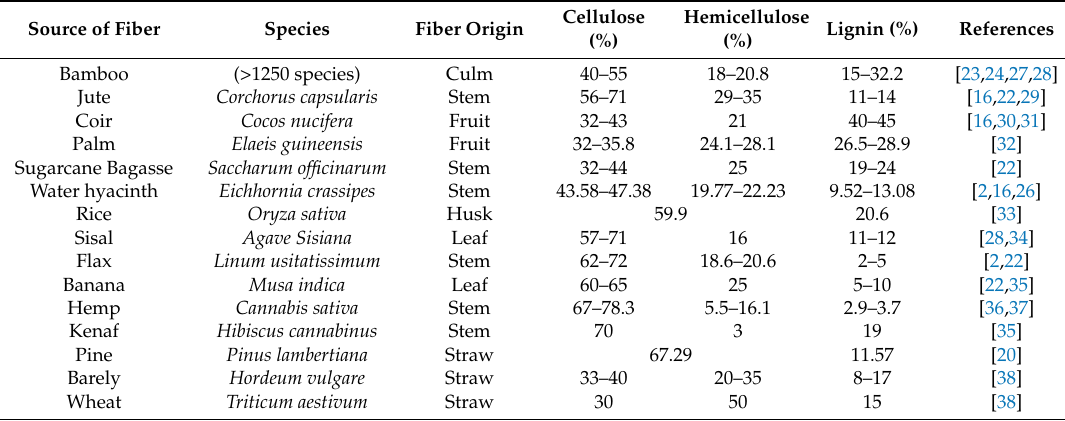
Table 2. Biochemical compositions of plant fibers with respect to their species and origins.